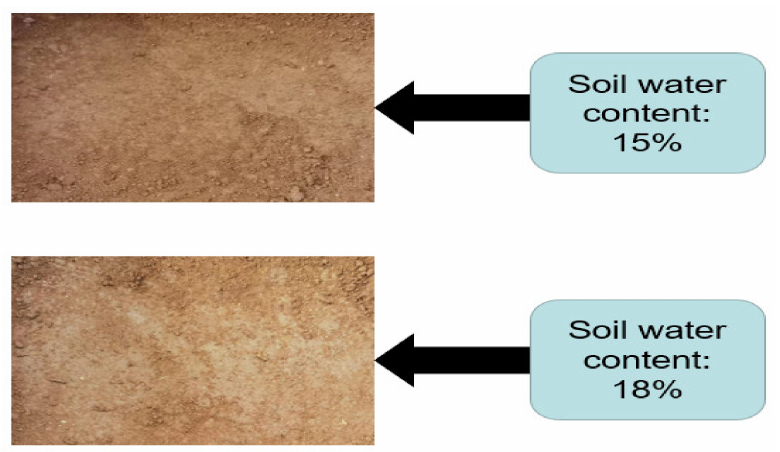
Figure 23. Soil moisture.